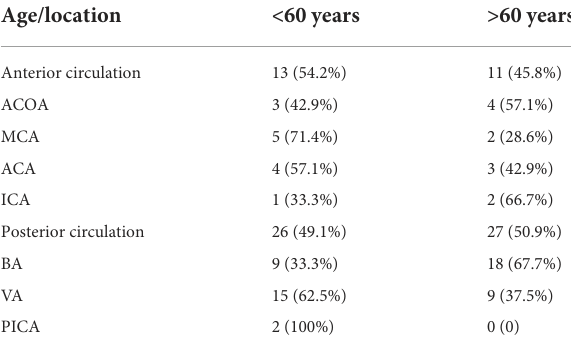
TABLE 3 Differences in the age in fenestration located in the anterior and posterior